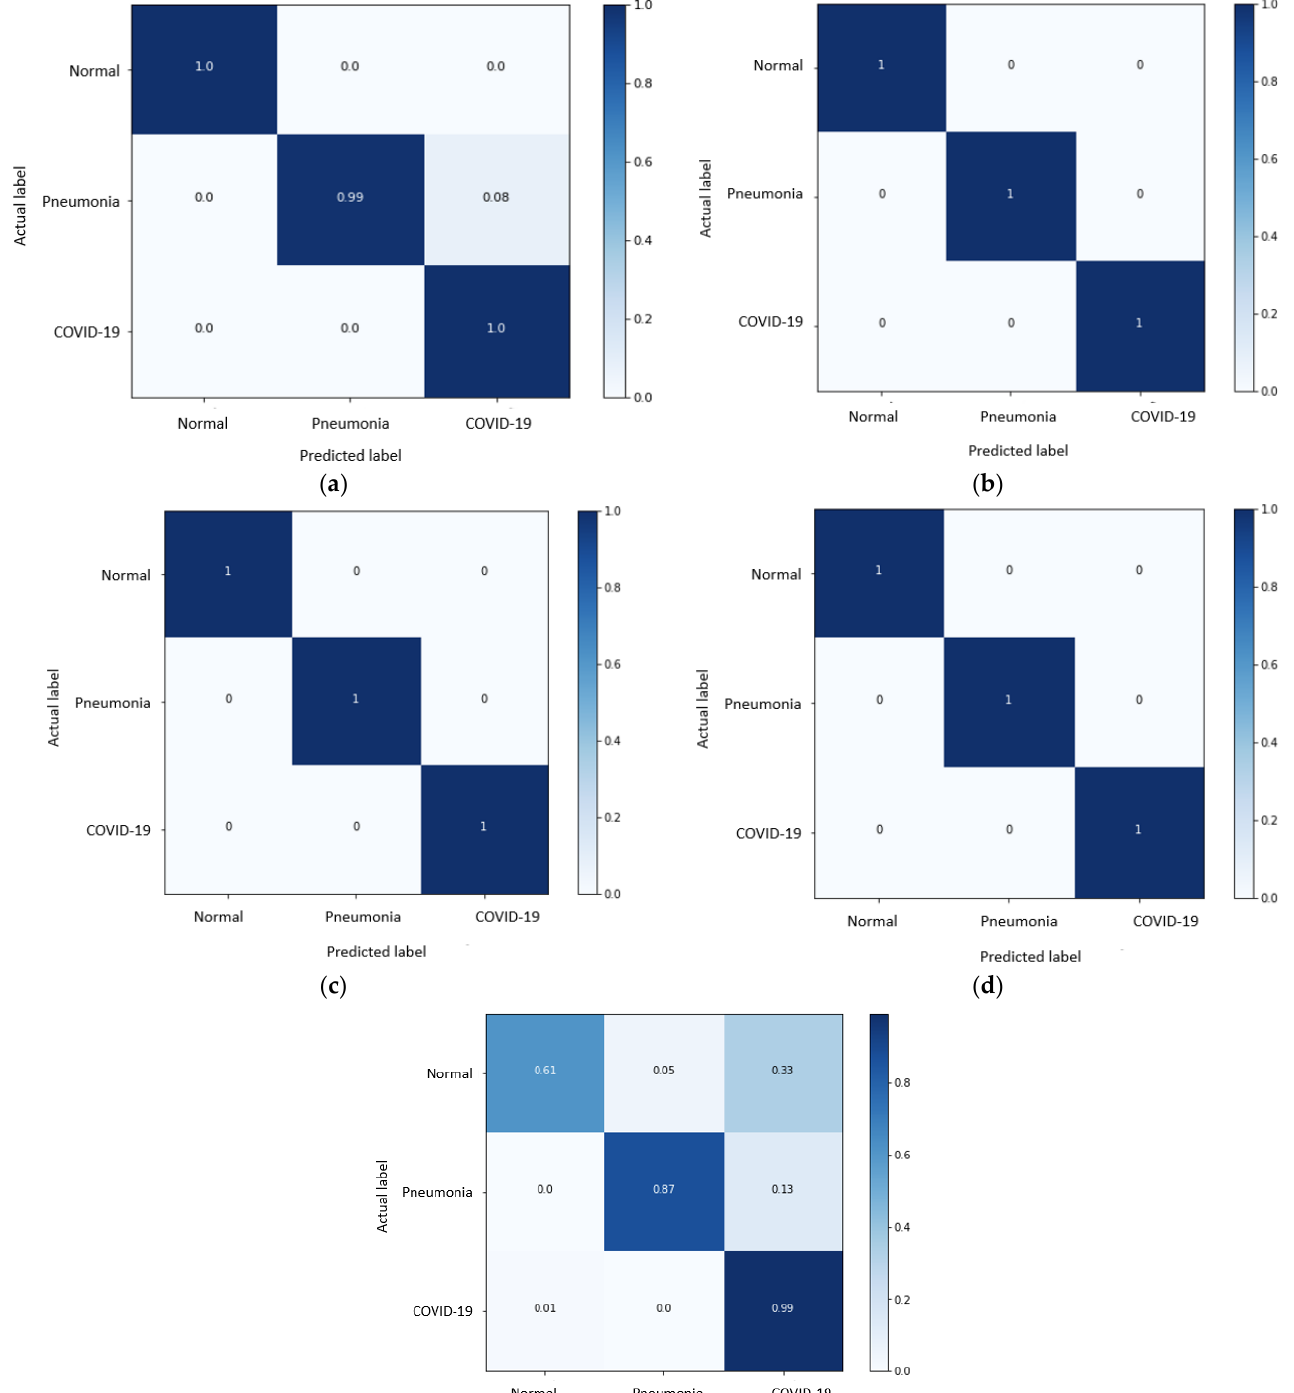
Figure 6. Confusion matrices of different 5-fold trials ( a – e ) of EfficientNet-B2. The rows represent the actual true values of the different classes; the columns represent the predicted values. Starting from the confusion matrices in Figure 6, we calculated the accuracy of the EfficientNet-B2 model on the three classes (normal, pneumonia, and COVID-19) and pre- sent the results in Table 3. Table 3. Accuracy per class (%) of the EfficientNet-B2 model with a transfer learning approach. We present the results of the five trials, where each trial is an experiment of the 5-fold cross-validation procedure. The last column represents the overall accuracy of the model. Normal Pneumonia COVID-19 Overall Accuracy